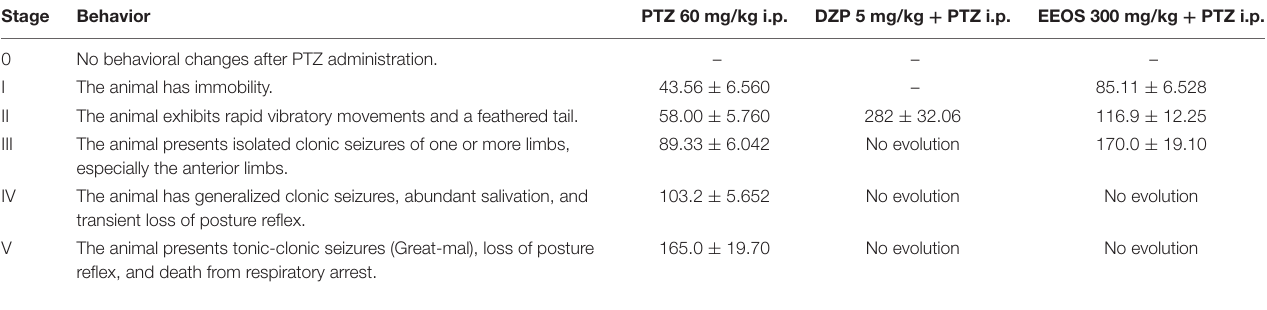
TABLE 1 | Behavioral characterization of seizures triggered by the administration of pentylenetetrazol (PTZ) and after previous administration of diazepam (DZP) or extract of Euterpe oleracea stones (EEOS) (latency in seconds).